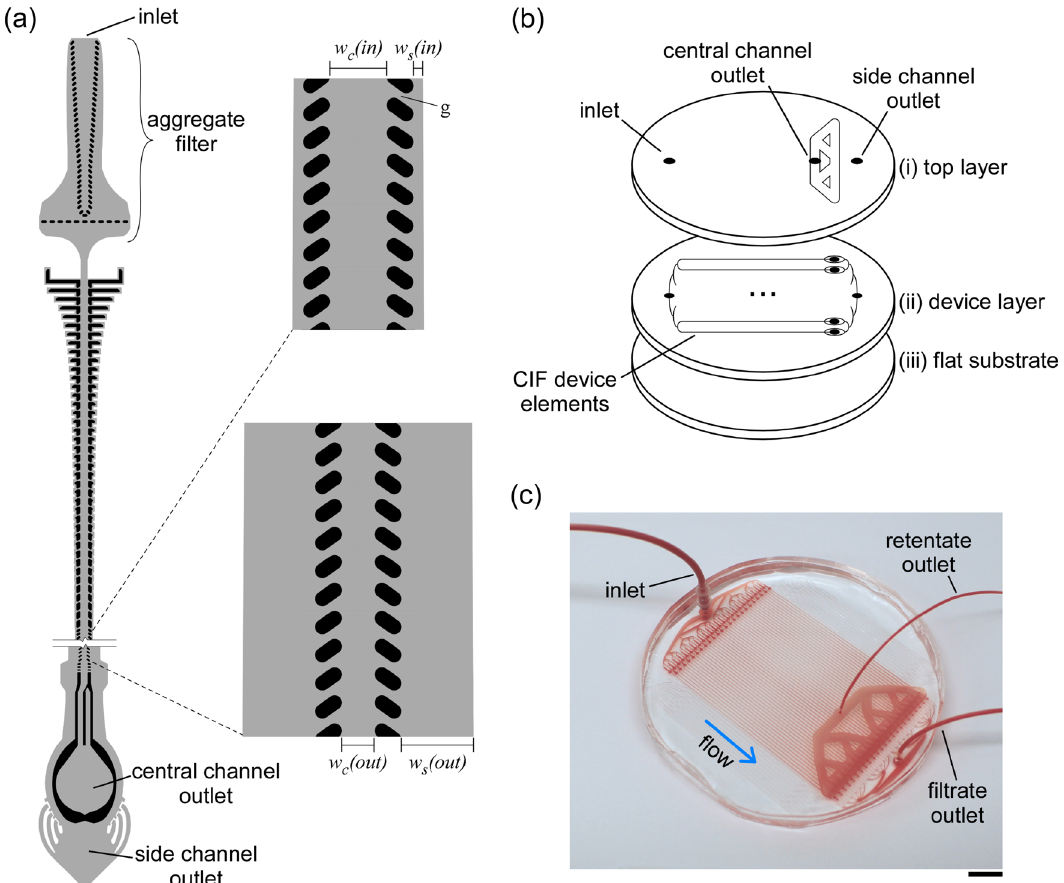
Figure 2. CIF-based microfluidic device. ( a ) Design of the CIF element. Width of the side channel near inlet w s (in) = 21 µm and near outlet w s (out) = 154 µm. Width of the central channel near inlet w c (in) = 120 µm and near outlet w c (out) = 70 µm. Filtration gap width g = 19 µm. Depth of all channels is 140 µm throughout. ( b ) Components of the multiplexed CIF device: (i) a ‘top layer’ containing a system of larger channels for collecting the central channel output (retentate) from each CIF element of the device, (ii) a ‘device layer’ consisting of individual CIF elements arranged in parallel, and (iii) a flat substrate for sealing the channels of the